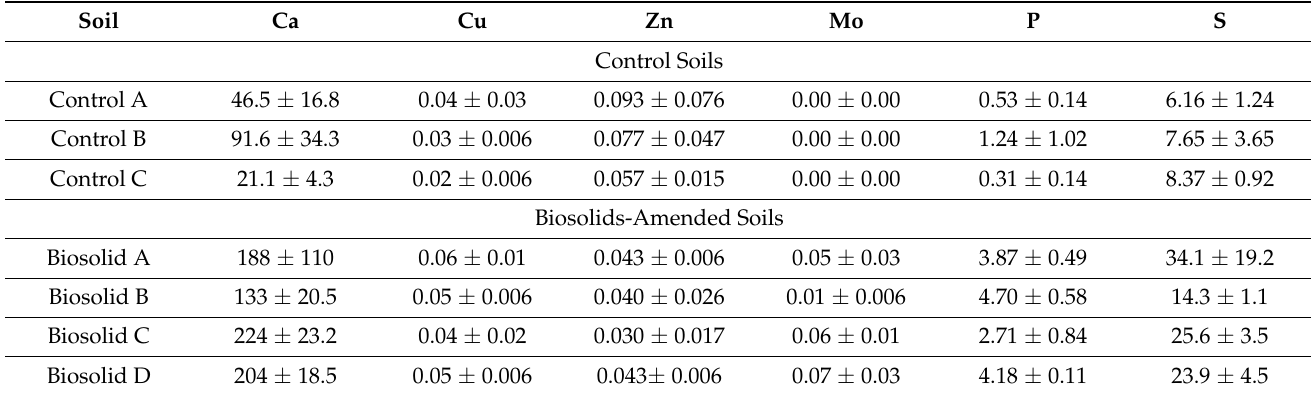
Table 5. Water-soluble elemental concentrations (mg L − 1 ) in leachates collected from biosolids- amended and control